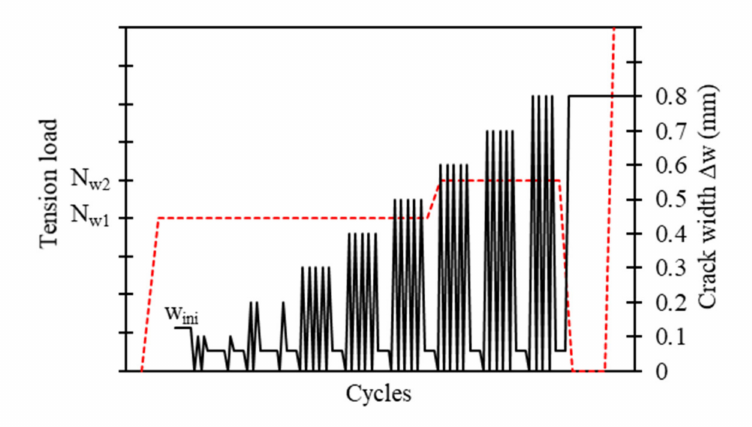
Figure 4. Schematic test procedure for crack cycling tests in test series C2.5. Redrawn on the basis of EOTA TR 049